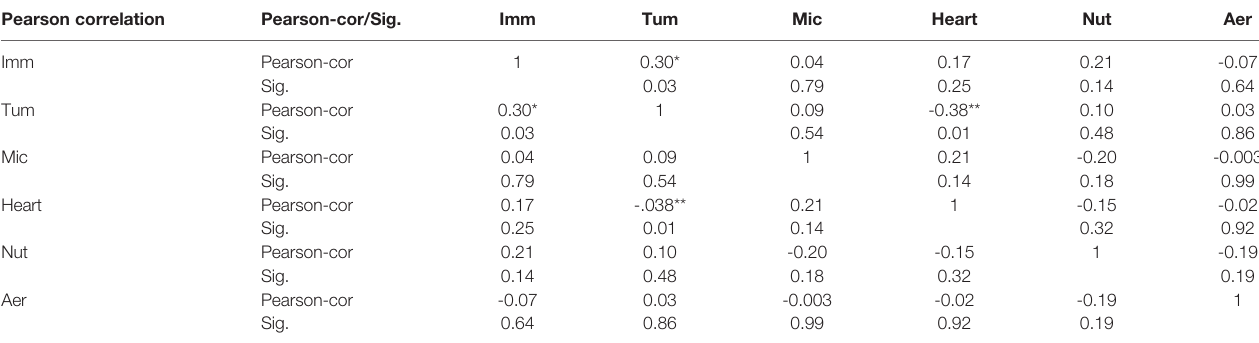
TABLE 2 | Correlation analysis table of each index. Pearson correlation